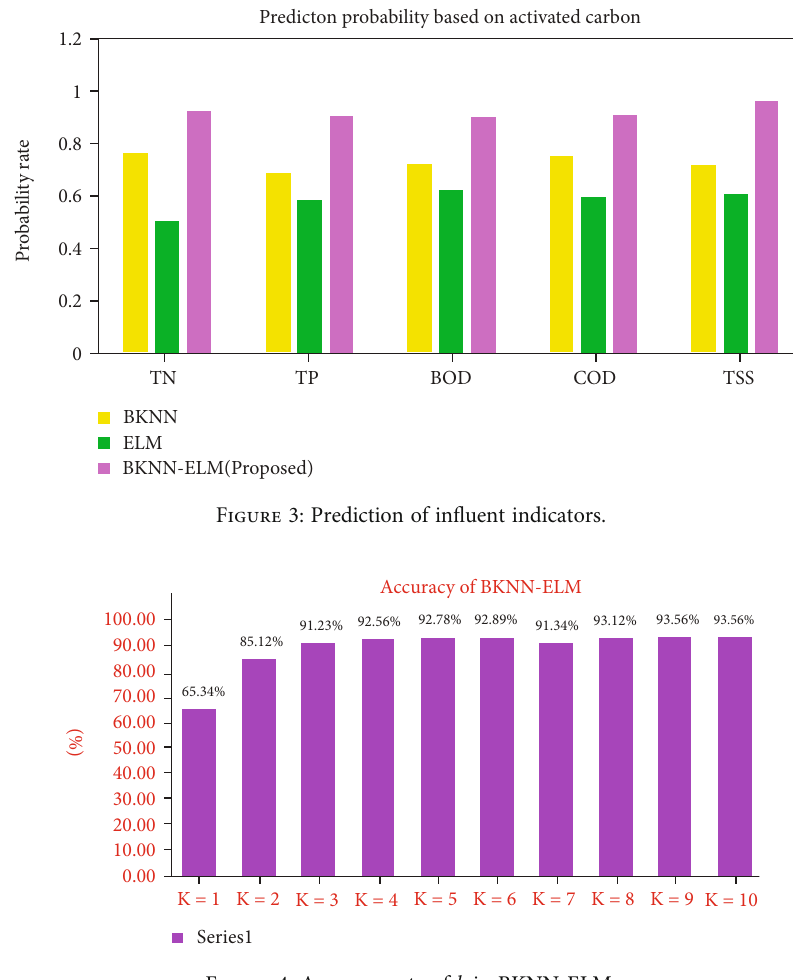
Figure 4: Accuracy rate of k in BKNN-ELM. Table 6: E ff ectiveness.